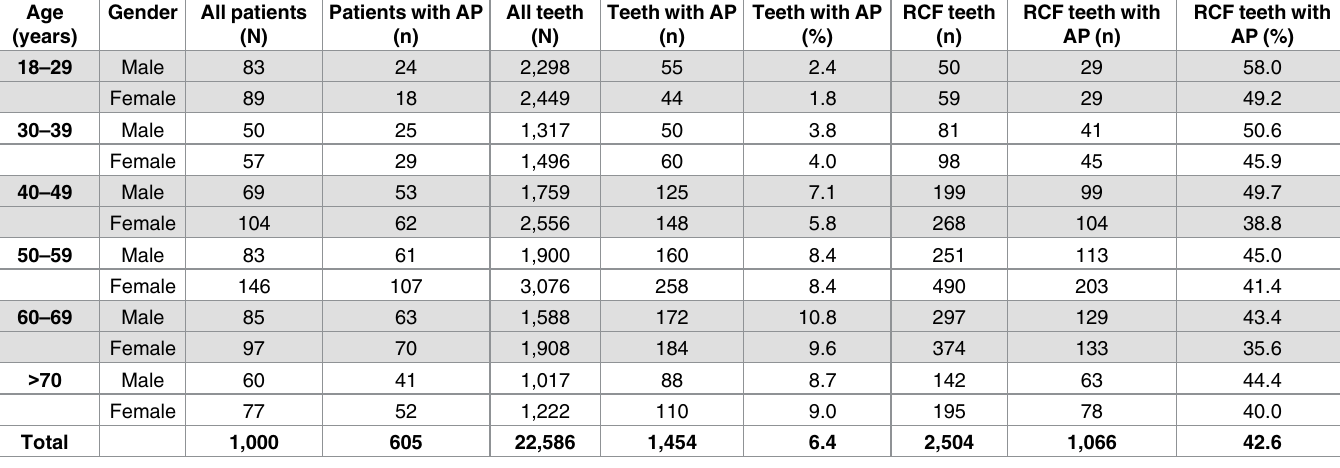
Table 2. Distribution of patients and (root canal filled) teeth according to age and gender. Age